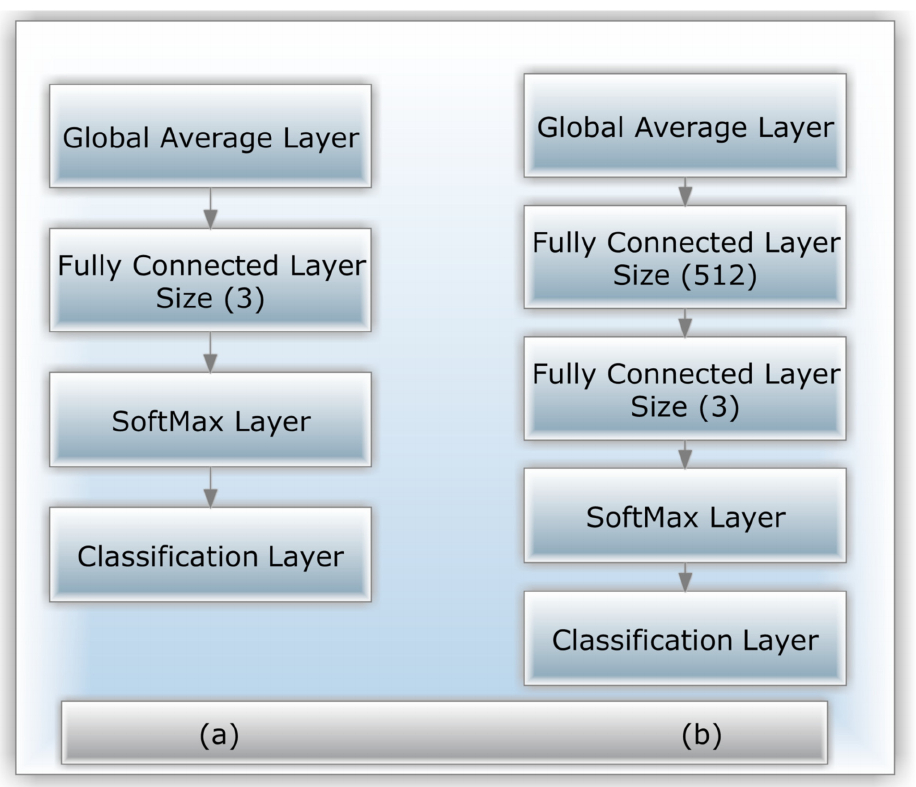
Figure 10. Versions of the Resnet-50 model that were modified; ( a ) the initial pre-trained model; ( b ) the addition of one FC.